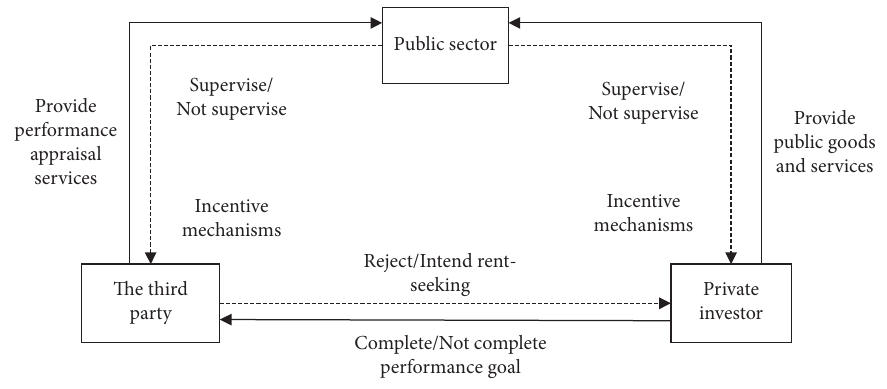
Figure 1: Logical relationship between the three